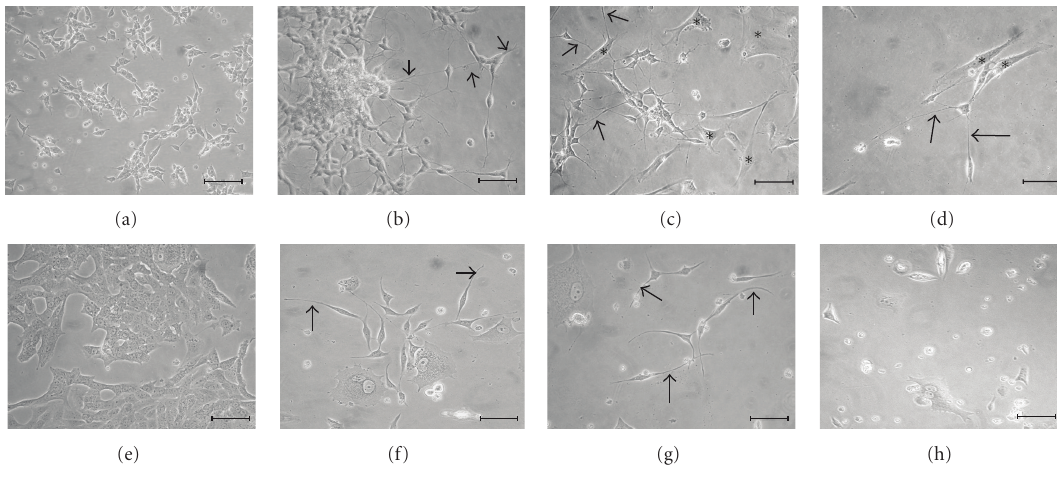
Figure 2: In vitro neurotrophic e ff ects of ATSC. LAN-5 human neuroblasts and PC12 rat cells were cultured either ATSC-conditioned medium or co-cultured with ATSC and morphological modifications were monitored over time: (a) LAN5 in standard culture medium; (b) LAN5 cultured in ATSC-CM for 72 hours; (c) and (d) LAN-5 co-cultured with ATSC using a cell density of 10 4 cell/cm 2 for both cell populations; (e) PC12 in standard culture medium; (f) PC12 cultured in ATSC-CM for 4 days; (g) PC12 cultured in β NGF 100 ng/mL for 4 days; (h) PC12 cultured in HDF-conditioned medium for 4 days. Arrows show evidence of neurite outgrowth; asterisk ( ∗ ) indicate ATSC in culture. Scale bar 100 μ m in all panels except for panel d = 10 μ m.